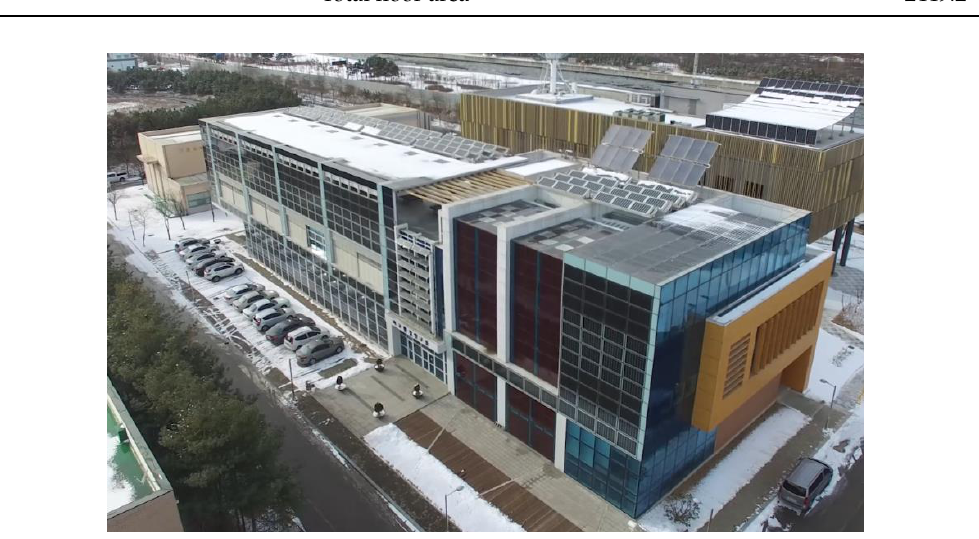
Figure 1. Photograph of the Carbon Zero Building.